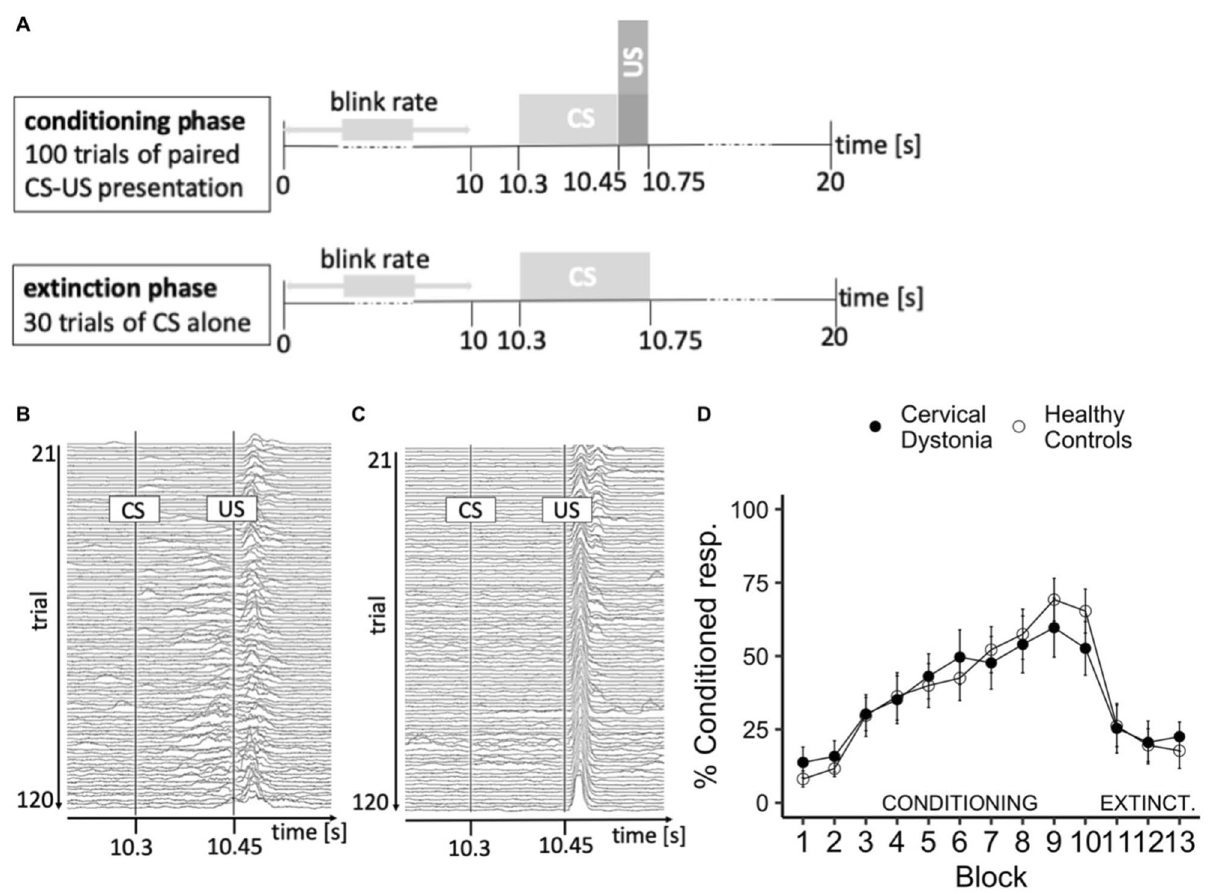
Figure 3. Classical eyeblink conditioning. ( A ) Schematic course of the experiment: In the conditioning phase a tone as the conditioning stimulus (CS; 550 ms, 88 dB), is paired with an air puff as the unconditioned stimulus (US; 100 ms, 110 kPa). In the extinction phase the CS is presented alone. ( B ) Example surface EMG activity of the orbicularis oculi muscle over the course of the conditioning phase of a participant that shows conditioning and ( C ) of a participant that does not exhibit a conditioned response to air puff stimulation. ( D ) Conditioning of the blink reflex is acquired in patients with cervical dystonia to the same extent as in healthy controls. Points represent percentage + SE of conditioned responses of the blink reflex per runs of ten